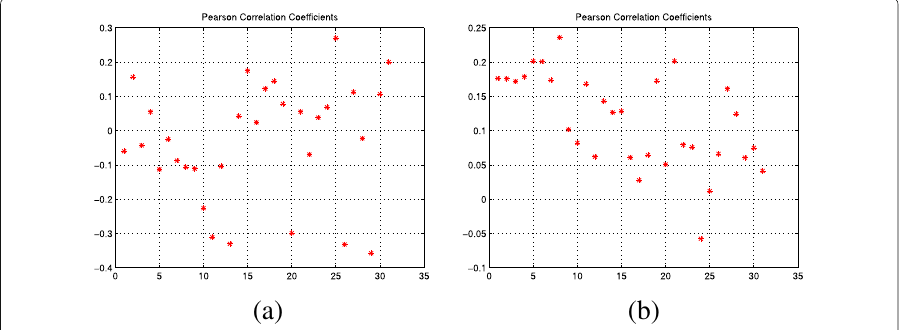
Fig. 6 Pearson Correlation Coefficients of all the metering points in IEEE 14 bus system. a T = 13. b T =